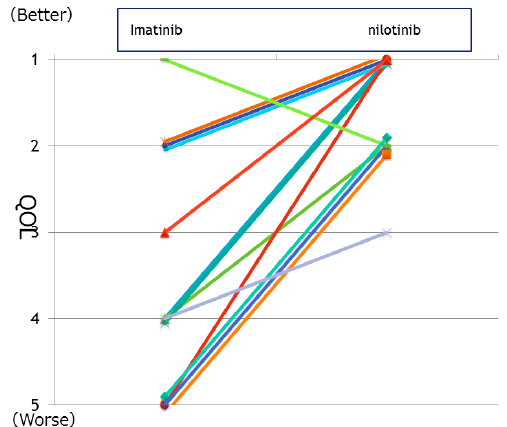
Figure 5. An interview form for QoL was prepared for all patients. Comparison of QoL score between IM group and NILO group.